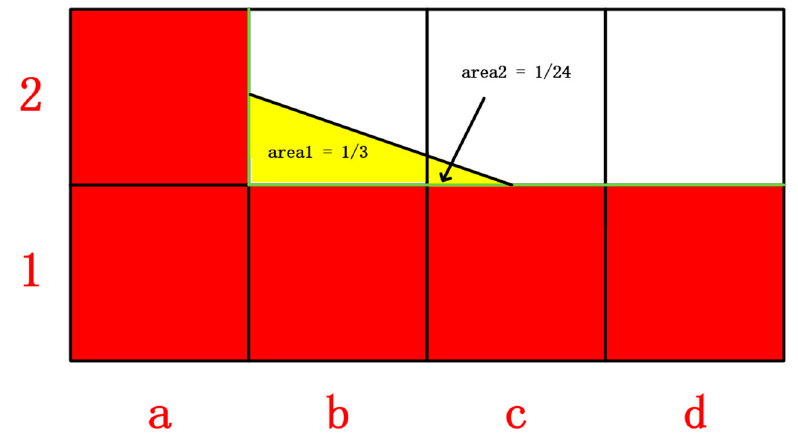
Figure 4. Process of the calculation of the blend weight coefficients.